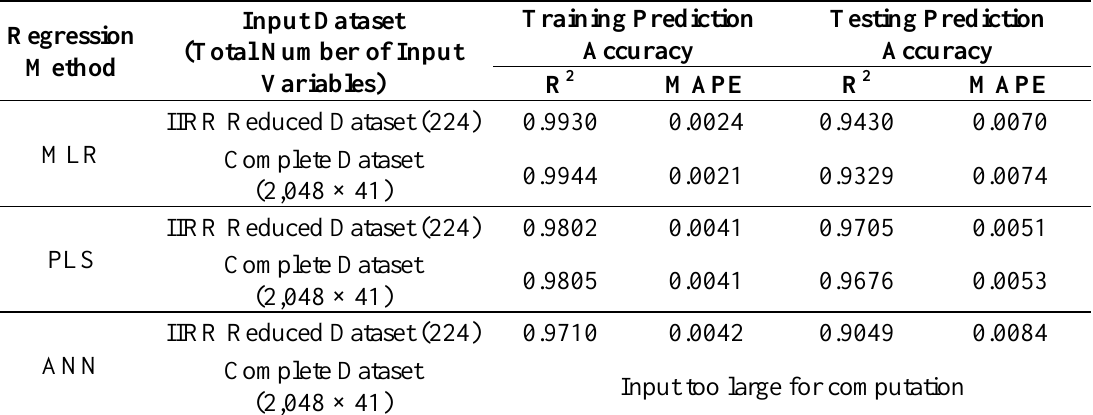
Table 2. Etch rate prediction accuracy comparison between original (full) OES dataset and the IIRR reduced dataset (with m = 0.01 in OPS threshold